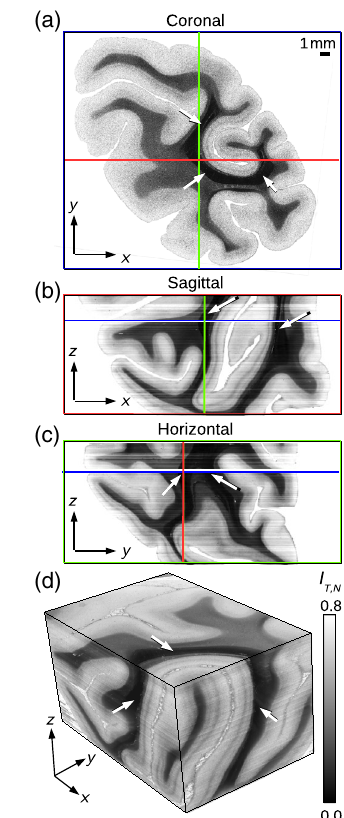
FIG. 13. 3D-reconstructed normalized transmittance images ( I ) of the right hemisphere of a vervet monkey brain (234 T;N consecutive sections from the occipital lobe) obtained from 3D- PLI measurements with 1 . 33 μ m pixel size. The brain is cut along the coronal plane ( xy plane), and the resulting brain sections are registered onto each other in the z direction. (a) – (c) Cross sections of the 3D volume shown along the coronal ( xy ), sagittal ( xz ), and horizontal ( yz ) planes. The colored lines indicate the position of the displayed xy , xz , and yz planes. (d) Detail of the 3D volume. The white arrows point to the sagittal stratum — a white matter structure that runs mostly perpendicular to the image plane (along the z direction) and which appears much darker in the transmittance images than the surrounding